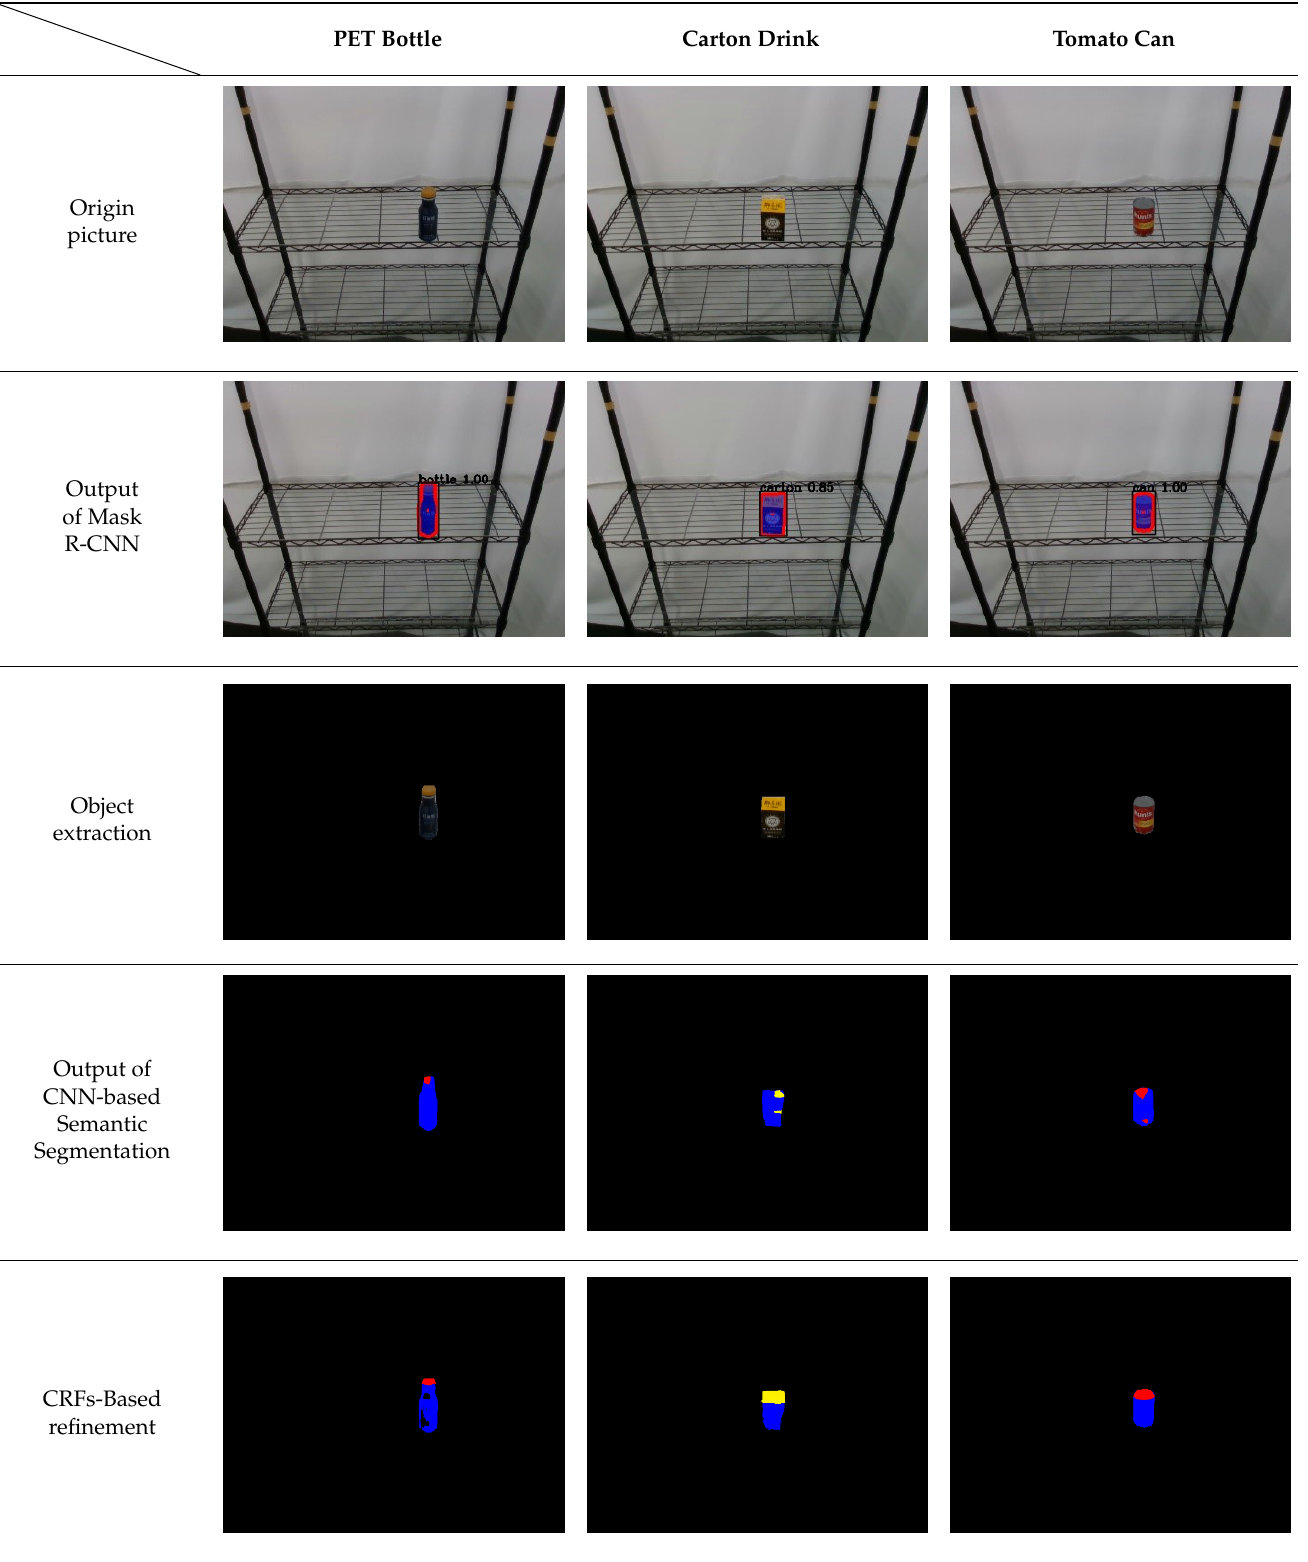
Table 2. Image processing results of three types of obtained by the proposed CNN-based object detection